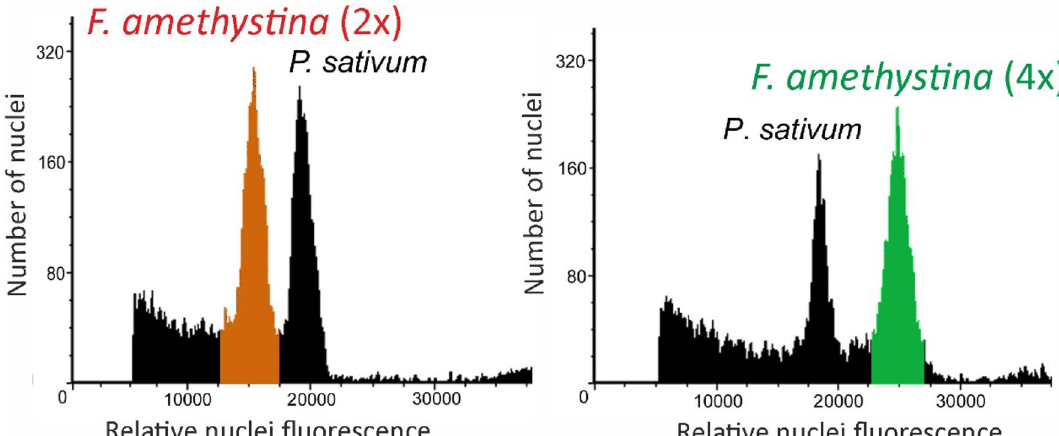
Figure 1. Histograms of relative nuclei fluorescence obtained after FCM analysis of Pisum sativum cv. ‘Set’ (internal standard) and example accession of studied cytotypes; representants are: F. amethystina (2x)— Corongis, E. Carpathians, Romania; and F. amethystina (4x)—Vlašić, Dinaric Mts., Bosnia and Herzegovina.